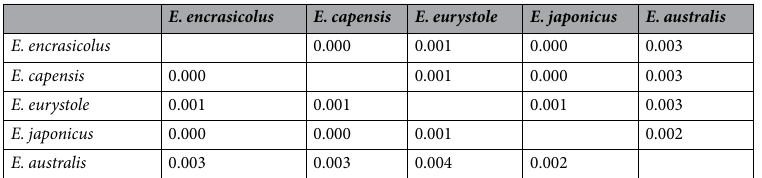
Table 3. Estimates of net evolutionary divergence between putative species of Old World Anchovies (below diagonal) and standard error values (above the